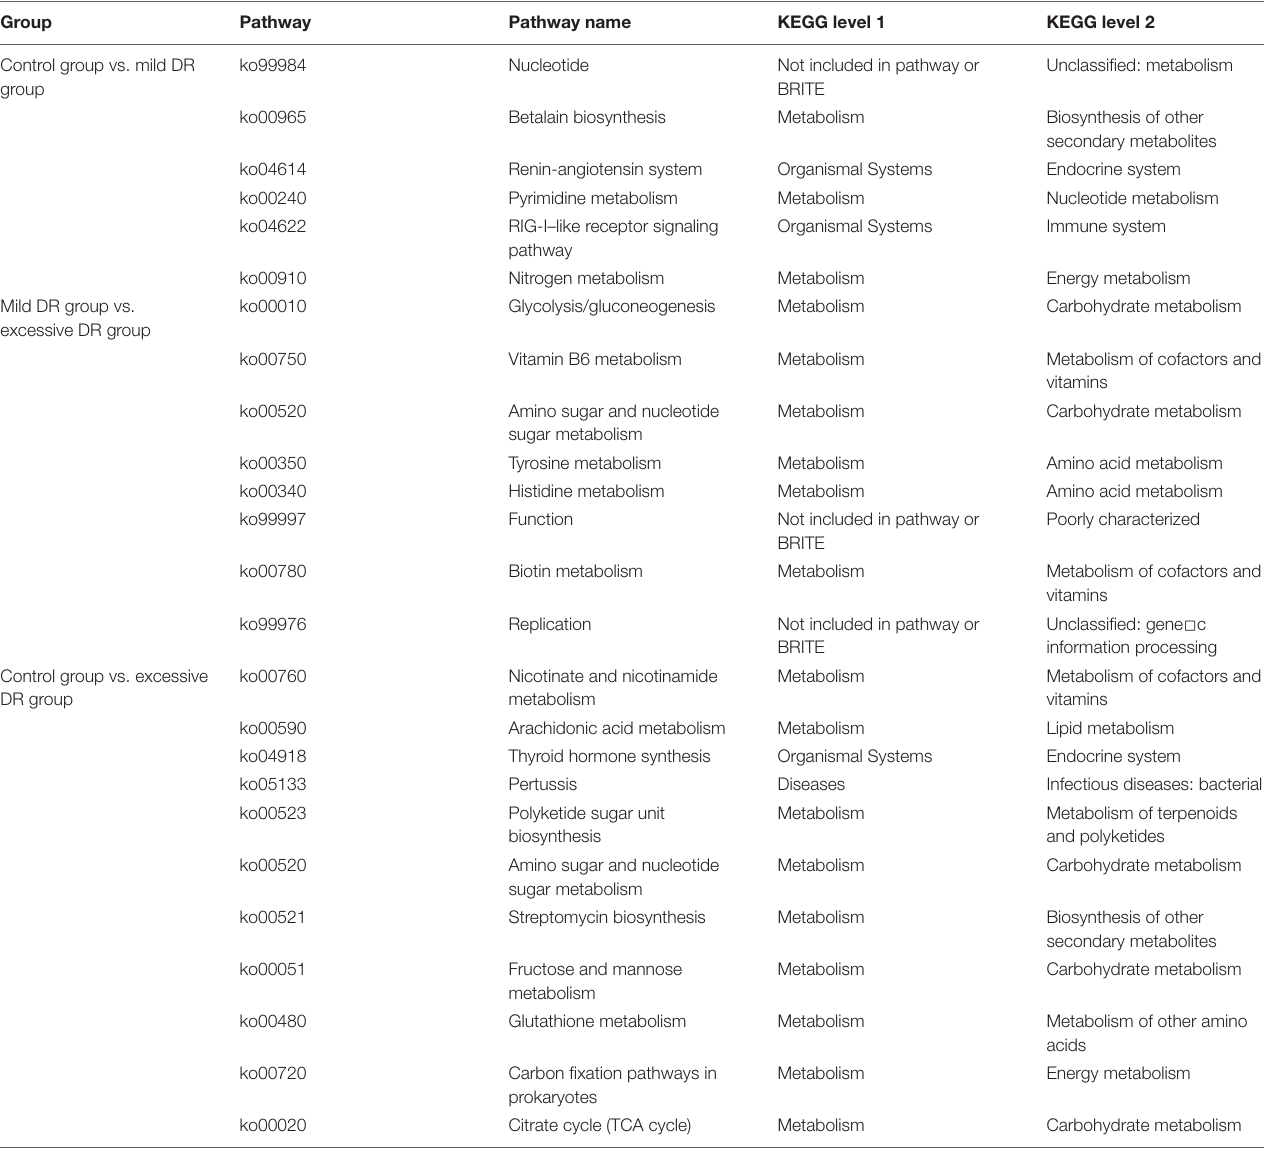
TABLE 1 | The results of KEGG enrichment analysis.